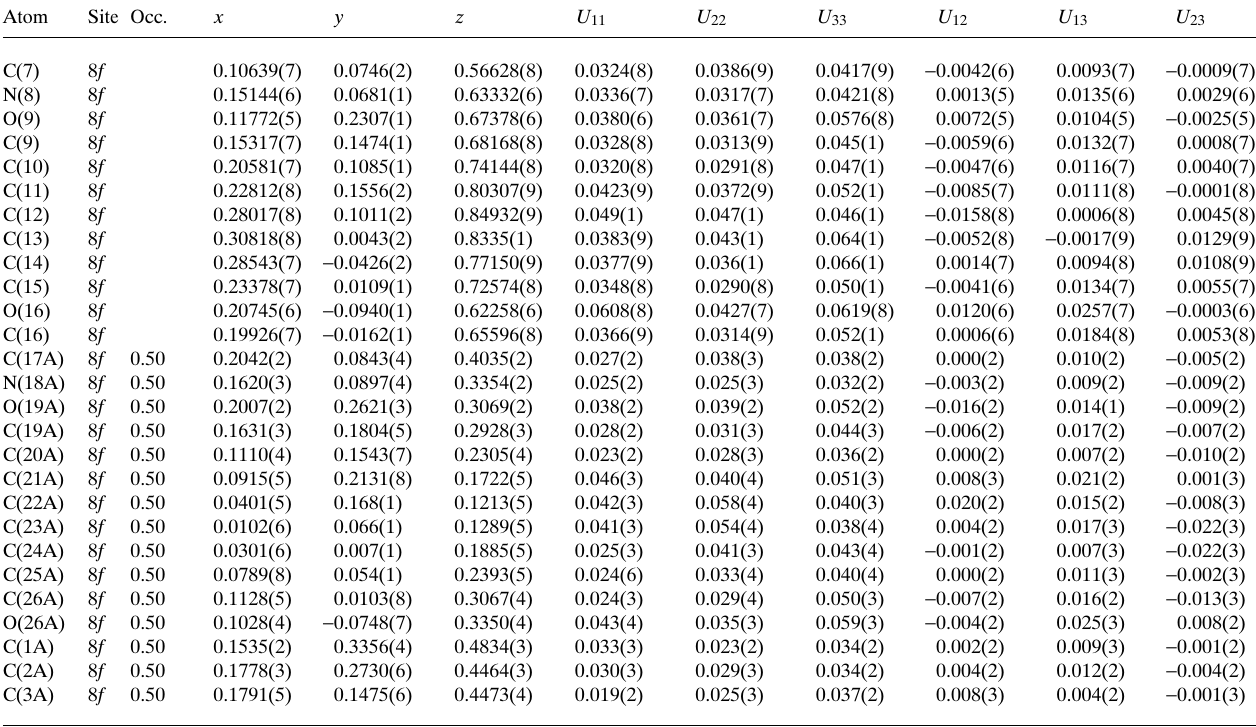
Table 3. Atomic coordinates and displacement parameters (in Å 2 ) .